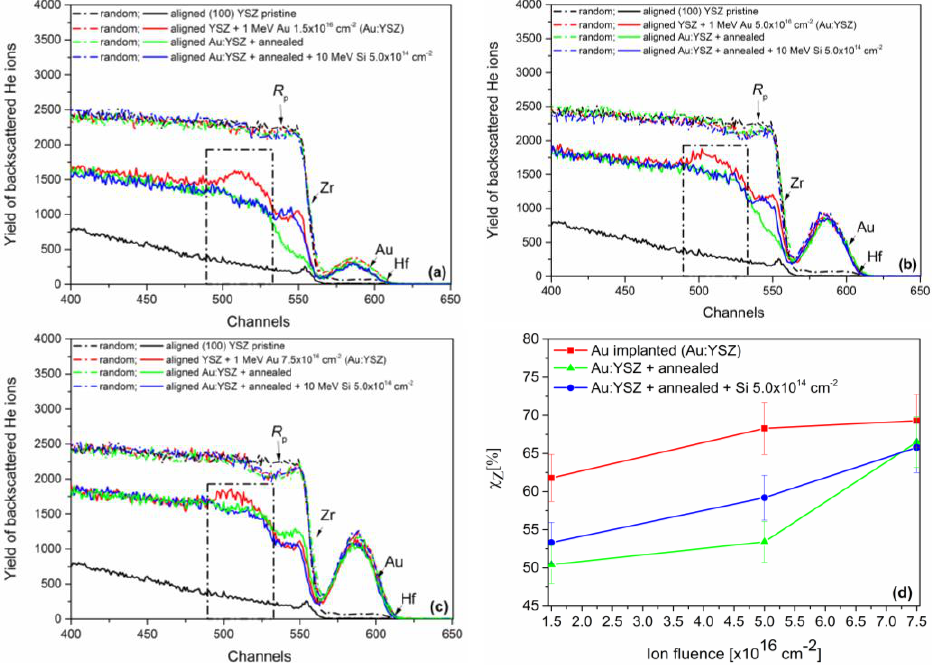
Fig. 1. The RBS-C spectra of the pristine, Au-implanted (with ion fluences of 1.5×10 16 cm −2 (a), 5.0×10 16 cm −2 (b) and 7.5×10 16 cm −2 (c)), annealed and subsequently Si-irradiated YSZ at ion fluence of 5.0×10 14 cm −2 for (100) orientation. The normalised yields (χ z ) are summarised as the function of Au + -ion fluence